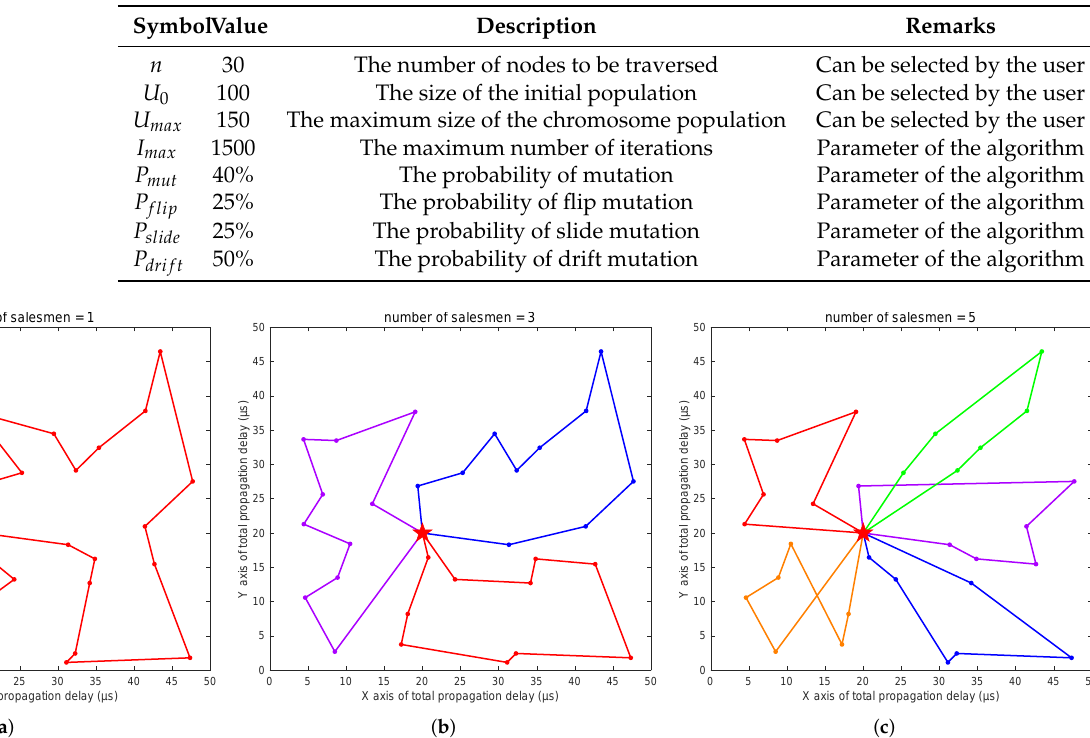
Figure 12. Comparison of traversal routes when the number of salesmen changed: ( a ) traversal route of one salesman; ( b ) traversal routes of three salesmen; ( c ) traversal routes of five salesmen. As the TT flows traversed through each SW, they consumed a certain amount of processing delay. We set a random processing delay for each SW with maximum values of 10 µ s, 15 µ s, and 20 µ s to simulate the change of the optimization target min ( T ) using Algorithm 1 when the number of salesmen m changed. The results are shown in Figure